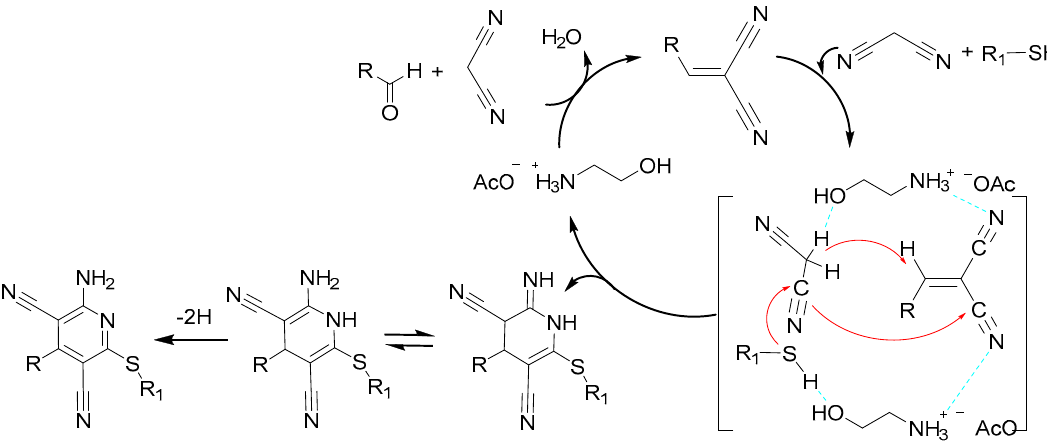
Figure 6. Reaction mechanism hypothesized for the mutual activation of the substrates and the ionic liquid.